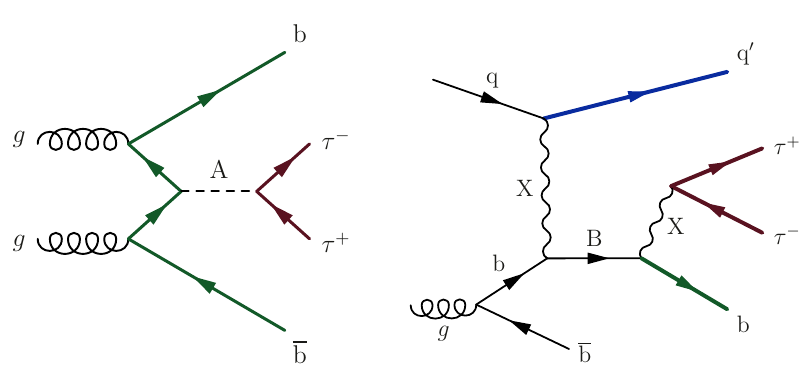
Figure 1 . Feynman diagrams of (left) a low-mass pseudoscalar Higgs boson (A) produced in association with bottom quarks, and (right) a bottom-like quark produced in t channel, which decays into X and a bottom quark. The particle X decays into a t -lepton